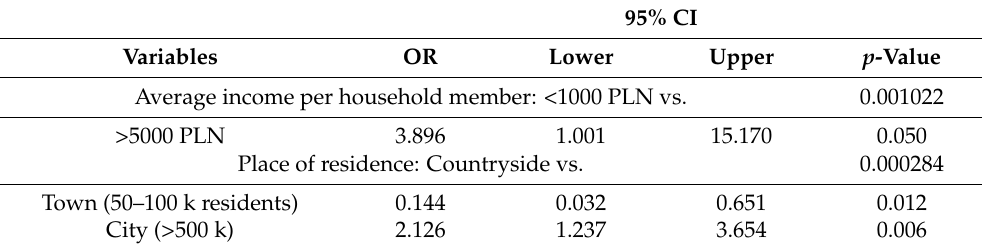
Table 6. Multivariate analysis regarding influenza vaccination status during current pregnancy.